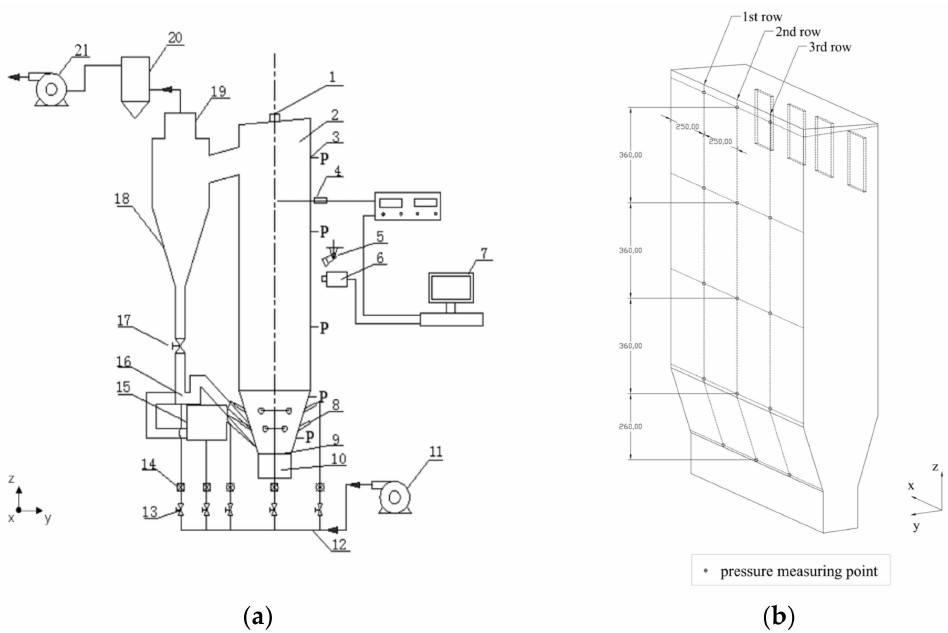
Figure 1. Schematic diagram and pressure measuring points of test rig: ( a ) schematic diagram of experiment. 1-bed material feeder, 2-furnace, 3-pressure taps, 4-pressure transmitter, 5-light, 6-high speed camera, 7-PC, 8-secondary air inlet, 9-distributor, 10-wind chamber, 11-input gas, 12-input gas duct, 13-ball valve, 14-rotameter, 15-External Heat Exchanger, 16-loop-seal, 17-cut off valve, 18- cyclone, 19-connection to the backpass, 20-dust collector, 21-induced draft fan; ( b ) furnace pressure measuring